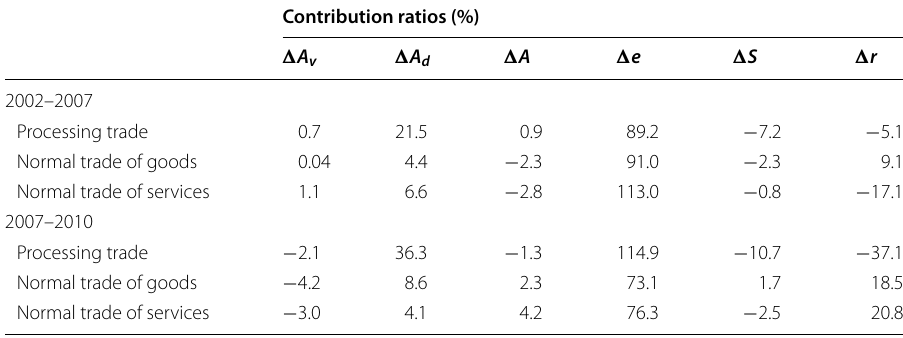
Table 5 Decomposition of the change in exported DVA by three kinds of trade: 2002–2007 and